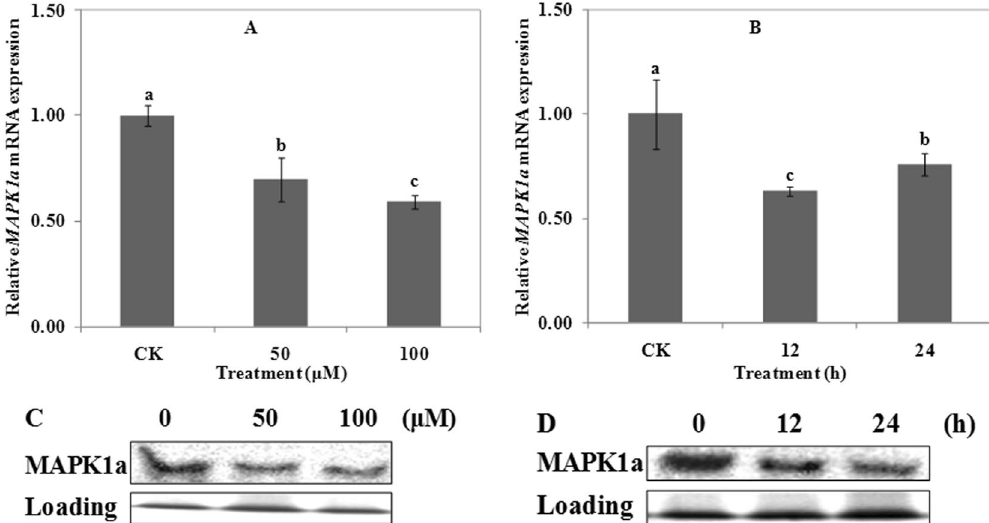
Figure 7. Expression and western blot detection of MAPK1a in wheat. Real time quantitative RT-PCR and western blot were used to assess MAPK1a expression in root apexes (0–20 mm) of wheat lines ET8. Four-day- old wheat seedlings were exposed to 0.5 mM CaCl 2 solution (pH 4.5) containing 0 (CK), 50 or 100 μ M AlCl 3 for 24 h ( A and C ). Four-day-old wheat seedlings were exposed to 0.5 mM CaCl 2 solution (pH 4.5) containing 0 or 50 μ M AlCl 3 for 0 (CK), 12 and 24 h ( B and D ). Data are means ± SD (n = 3). Small letter differences in the same figure mean significant difference at P < 0.05.